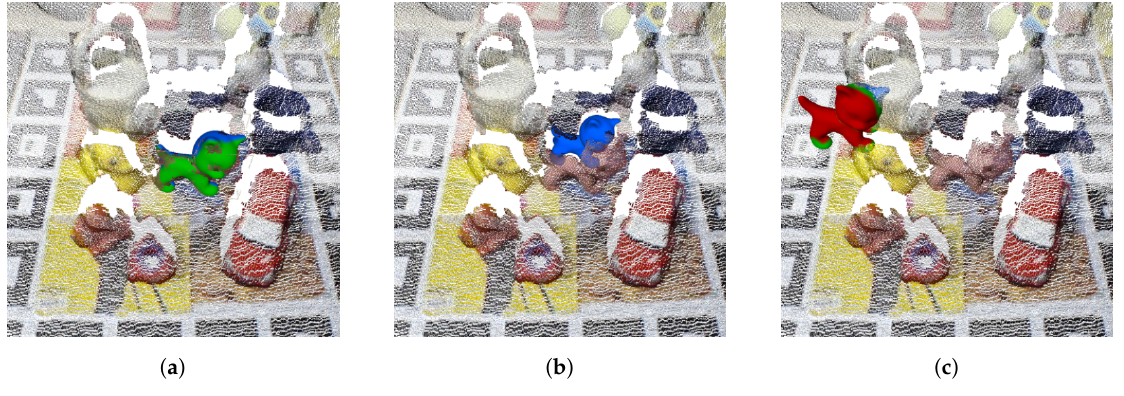
Figure 8. Model surface points classification regarding its distance to the scene data from the camera view. Green, blue and red colors label inlier, occluded and non-consistent points, respectively on the cat model surface. ( a ) matching pose; ( b ) occluded pose; ( c ) non-consistent